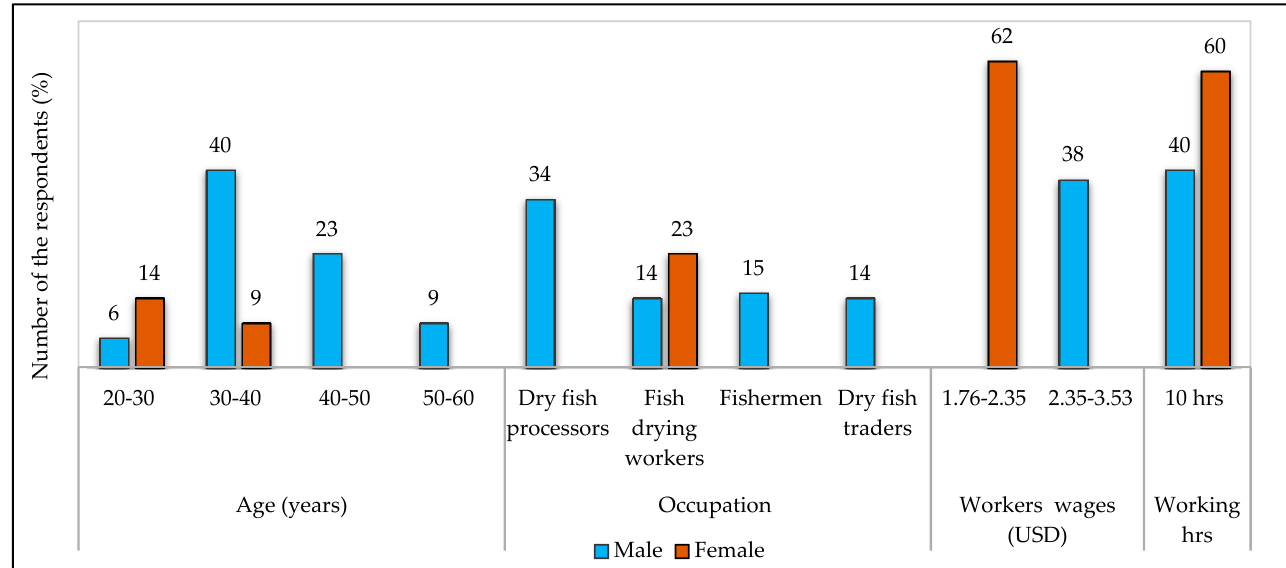
Figure 4. Gender participation profile of the fish drying community living in Chitapara. 3.3. Reasons behind Employing Children in Drying Respondents were asked why children were employed, in which 57% of the dried fish processors and owners of Nazirertek reported engaging children at the request of their parents; 39% thought the area was suitable for child labor, and 4% said some parents